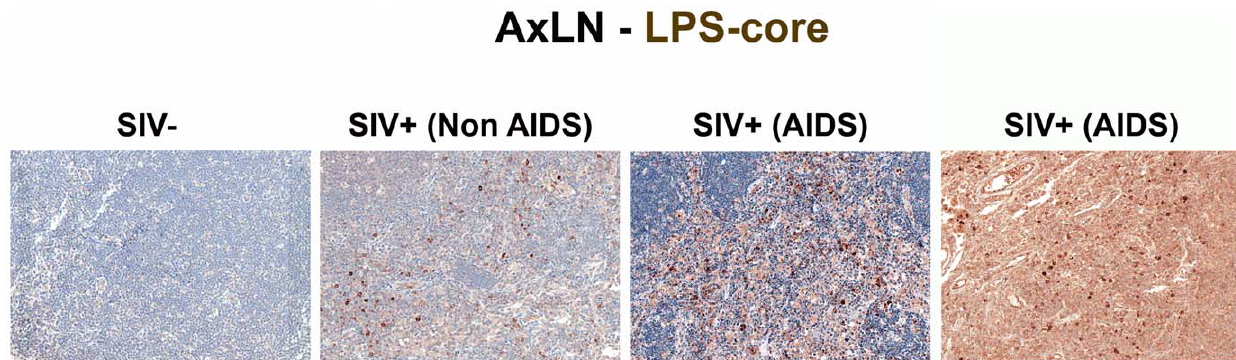
Figure 4. Identification of systemic microbial translocation in distant AxLN of chronically SIV + RMs. Representative images (200 6 ) of the paracortex of AxLN stained for LPS-core antigen (brown). Note the increased accumulation of microbial products within the paracortex, germinal centers, and medullary chords of the lymphatic tissue, with progressive SIV infection in chronically SIV + RMs, but the paucity of LPS staining seen in SIV-uninfected RMs.